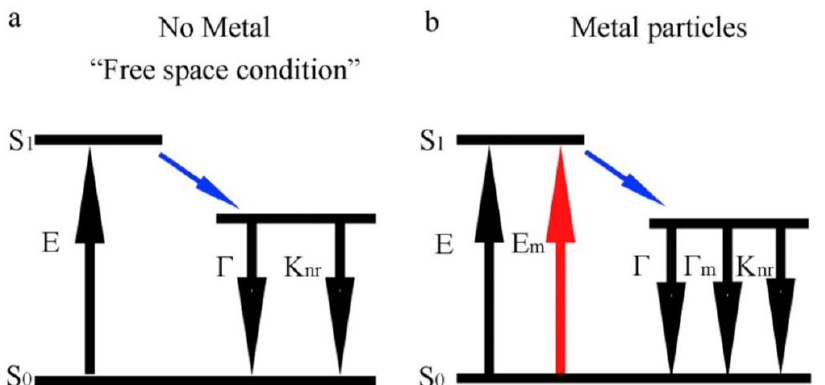
Figure 17. Classical Jablonski diagram for the free-space condition ( a ) and the modified form in the presence of metallic particles ( b ). E indicates excitation; E m indicates metal-enhanced excitation rate; Γ indicates radiative rate; K nr indicates non-radiative decay rates for excited state relaxation and Γ m indicates radiative rate in the presence of metal. (Reprinted from [134]; with the permission of Else- vier).